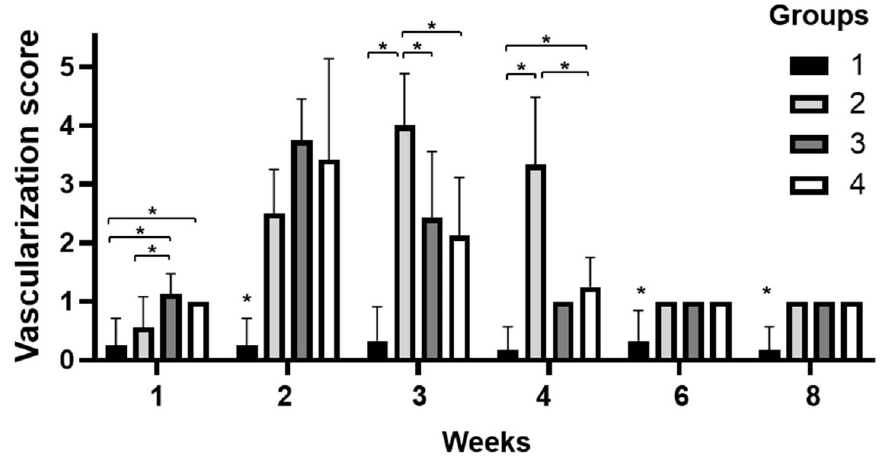
Figure 3. Corneal vascularization after surgery was scored. Neovascularization was established in groups 2, 3, and 4 within two weeks after surgery. Vascularization was generated faster in groups 3 and 4 than in group 2, and peaked at two weeks. In contrast, in group 2, vascularization peaked at three weeks. The rate of regression of vascularization was faster in groups 3 and 4 than in group 2. On the other hand, group 1 showed no neovascularization during all processes. Severity of opac- ity was increased in all groups. The number of samples in each group is indicated in Table S2. *, p ≤ 0.05.